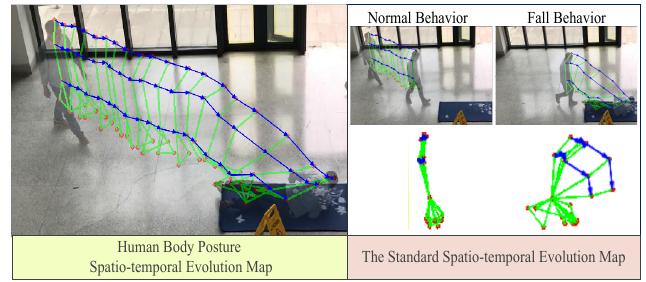
Figure 3. The standard spatio-temporal evolution map based on five-point inverted pendulum model. The left shows spatio-temporal evolution map describes the human body motion at the complete time